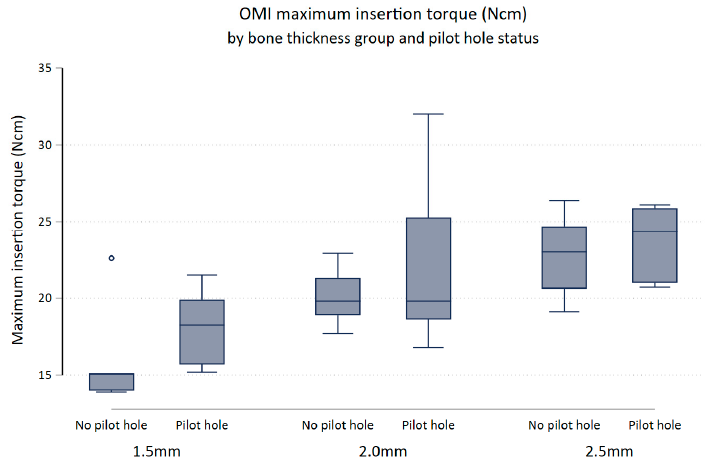
Figure 4. Box plot of maximum insertion torque (Ncm) comparing no pilot hole (NoPH) to pilot hole (PH) for each bone thickness. (PH) for each bone